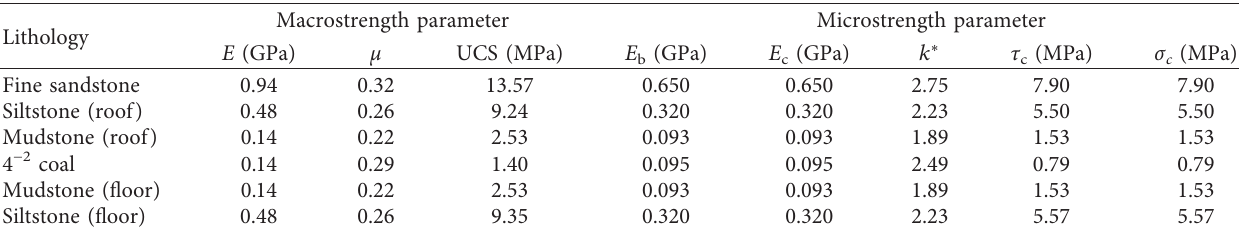
Table 2: The macro-micro parameter calibration for the strength parameters of the different lithologies.